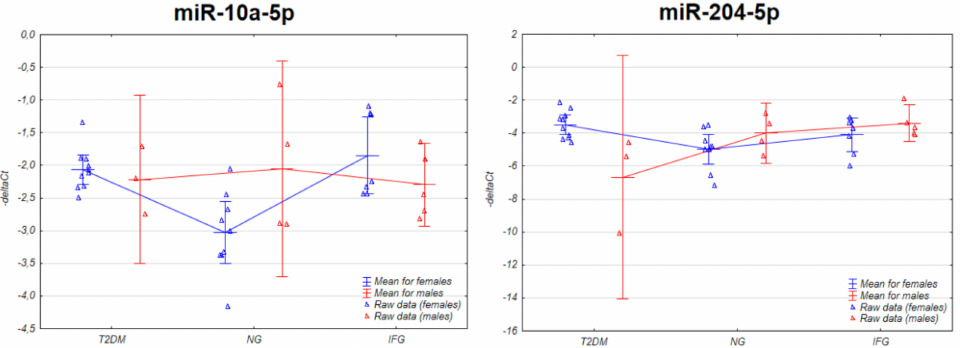
Figure A5. Plots for miR-10a-5p and miR-204-5p showing mean -deltaCt values with regard to studied group and sex for all study subjects (N = 38). Two-way ANOVA indicated significant interaction between study group and sex for both molecules ( p <